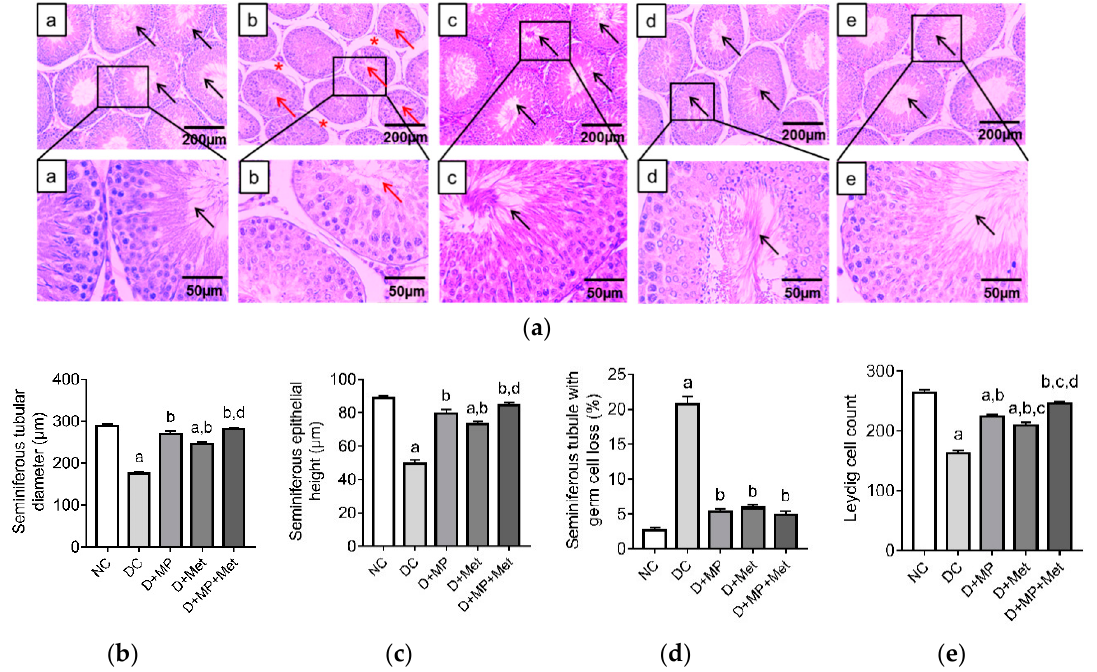
Figure 2. Representative photomicrographs of the testes in ( a ) NC, ( b ) DC, ( c ) D+MP, ( d ) D+Met and ( e ) D+MP+Met groups ( a ). The testes histology for DC group showed numerous seminiferous tubules with incomplete spermatogenesis (red arrows), and large intertubular spaces (red asterisk), relative to NC and the treated groups, which showed numerous seminiferous tubules with complete spermatogenesis (black arrows) (haematoxylin and eosin staining; magnification: ×100 and ×400; scale bars: 200 μ m and 50 μ m, for upper and lower panels, respectively). For ( b ) seminiferous tubular diameter, ( c ) seminiferous epithelial height, ( d ) seminiferous tubule with germ cell loss and ( e ) Leydig cell count, values are mean ± SD, n = 8. a p < 0.05 versus NC, b p < 0.05 versus DC, c p < 0.05 versus D+MP, d p < 0.05 versus D+Met (one ‐ way ANOVA followed by Tukey’s post ‐ hoc test). NC: normoglycaemic control, DC: diabetic control, D+MP: diabetic rats treated with Malaysian propolis, D+Met: diabetic rats treated with metformin, D+MP+Met: diabetic rats treated with Malaysian propolis + metformin.